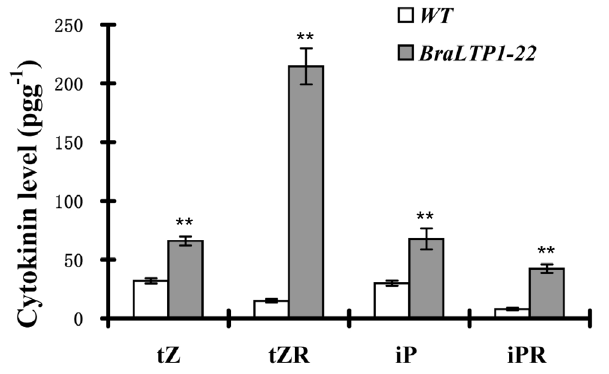
Figure 8. Cytokinin content in BraLTP1 overexpressing leaves. Amounts of tZ, tZR, iP, and iPR were measured in leaves of 4-week-old BraLTP1-22 and wild type (WT). Data are presented as mean 6 SD (n=3).